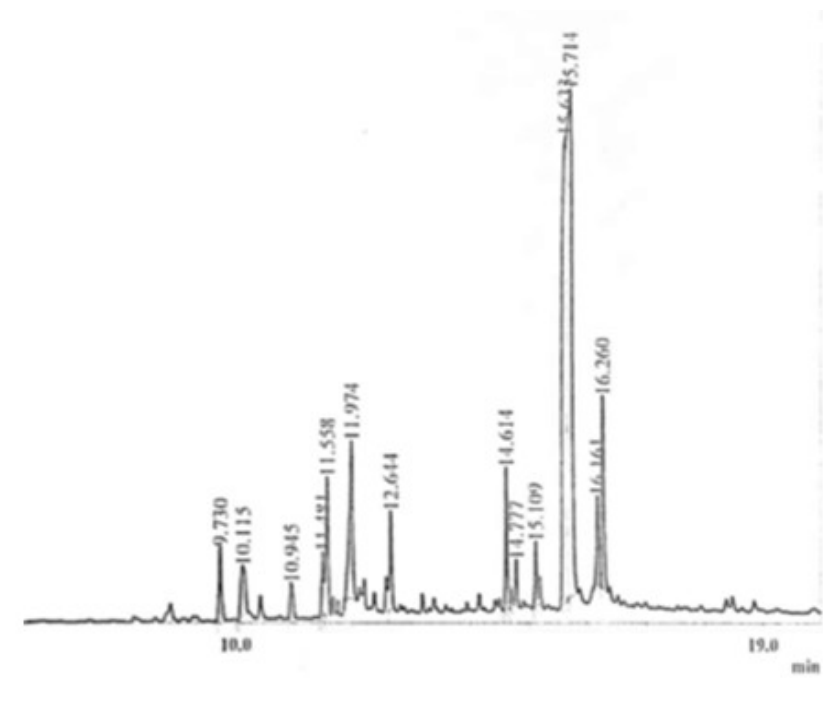
Figure 1. GC-MS chromatogram of n-Hexane fraction of A. americana.